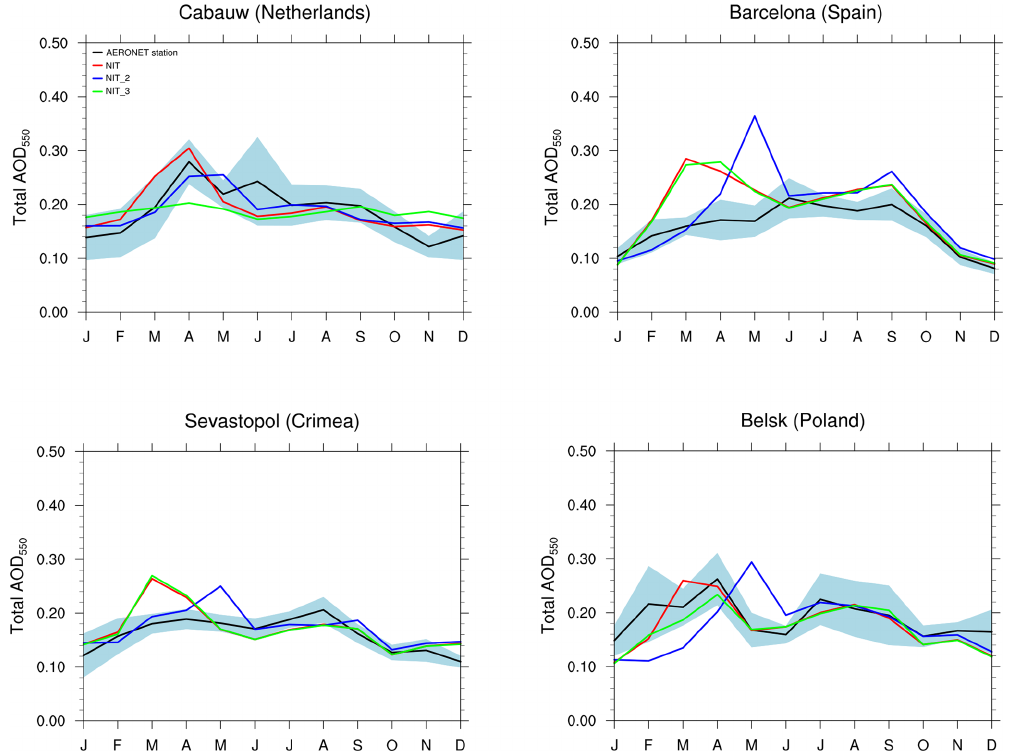
Figure 10. Comparison of the monthly means (2003–2012) of aerosol optical depth (at 550nm) simulated by the ALADIN-Climate model, with measurements at four AERONET stations for NIT (red), NIT_2 (blue) and NIT_3 (green) simulations. Observations are in black and the standard deviation associated with observations is in light blue.